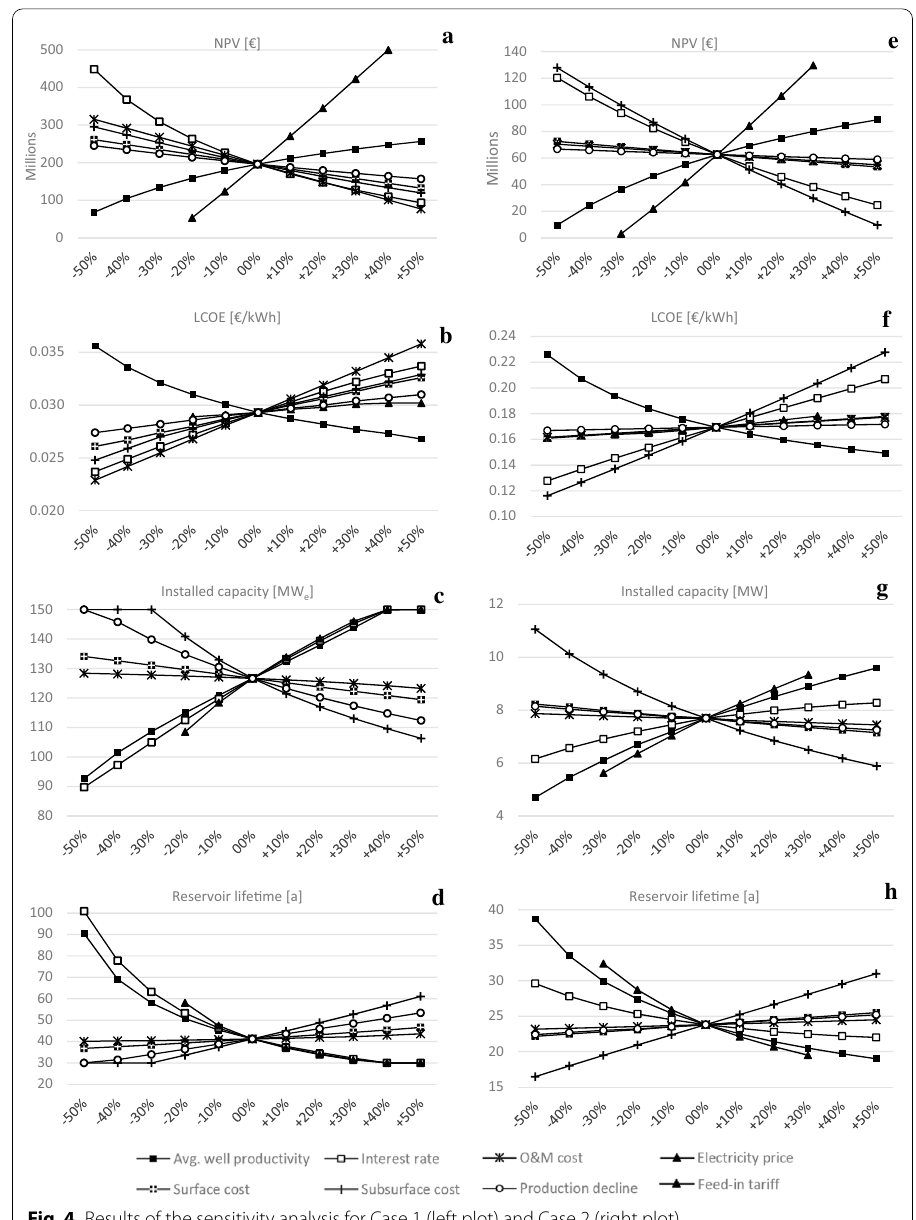
Fig. 4 Results of the sensitivity analysis for Case 1 (left plot) and Case 2 (right